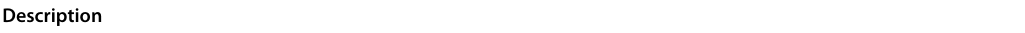
Table 6 Segment content coding